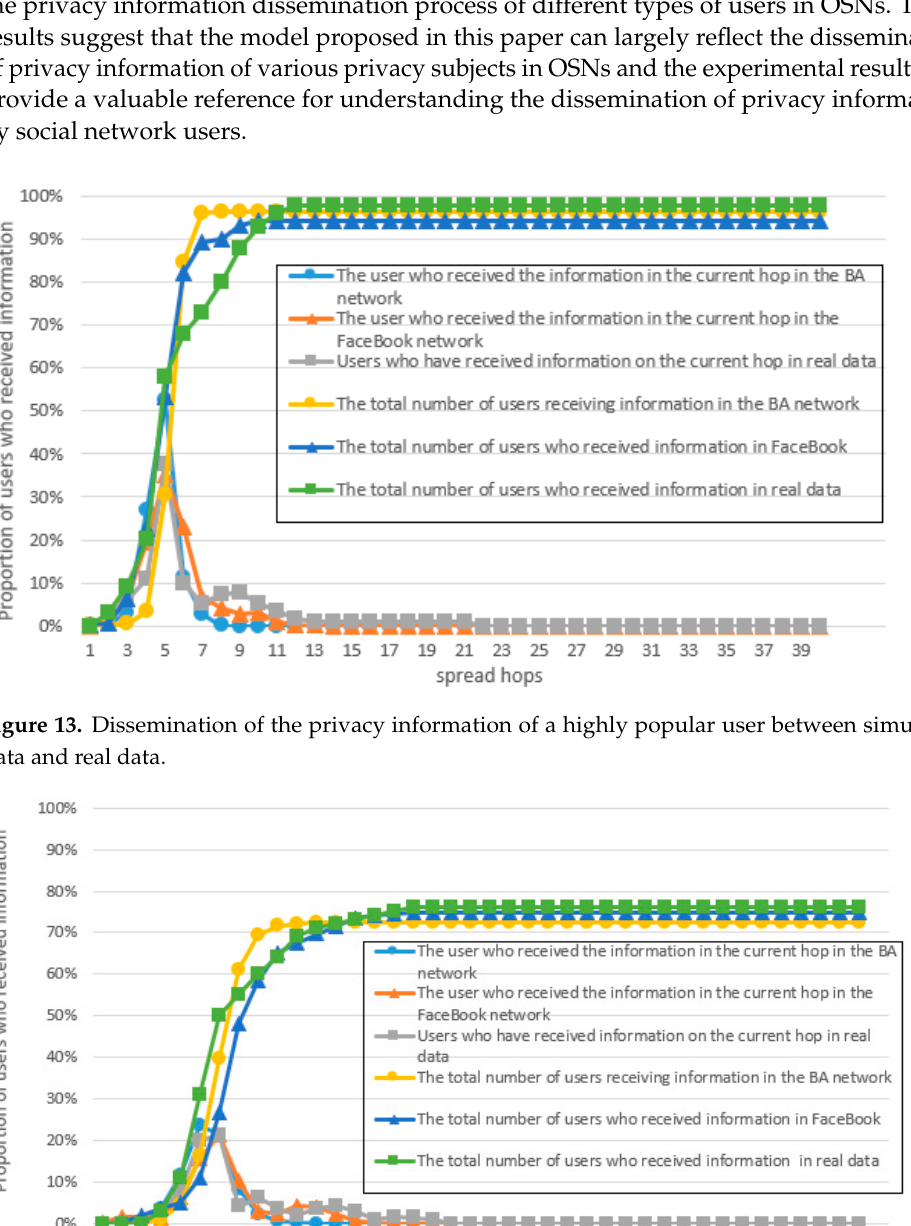
Figure 15. Dissemination of the privacy information of a low popular user between simulated data and real data. The following conclusions can be drawn after comparison to the real data: the higher the intimacy between the initial communication node and the privacy subject, the more likely the receiver will protect the privacy and block the spread of privacy information. In contrast, the lower the intimacy, the easier it is to spread the privacy information. Users tend to disseminate the privacy information of users with high popularity. The scope of privacy information dissemination of high popularity users is much larger than that of low popularity users. The higher the popularity, the faster the information dissemination, and it can be spread throughout the whole only after a few rounds of forwarding net. The smaller the Nash equilibrium probability that the receiver likes, the greater the probability that the receiver likes it, the greater the possibility that the sender chooses to send, and the wider the coverage of information. 5. Conclusions This paper firstly introduced the current stage of research on privacy information dissemination in online social networks by analyzing their characteristics and limitations.